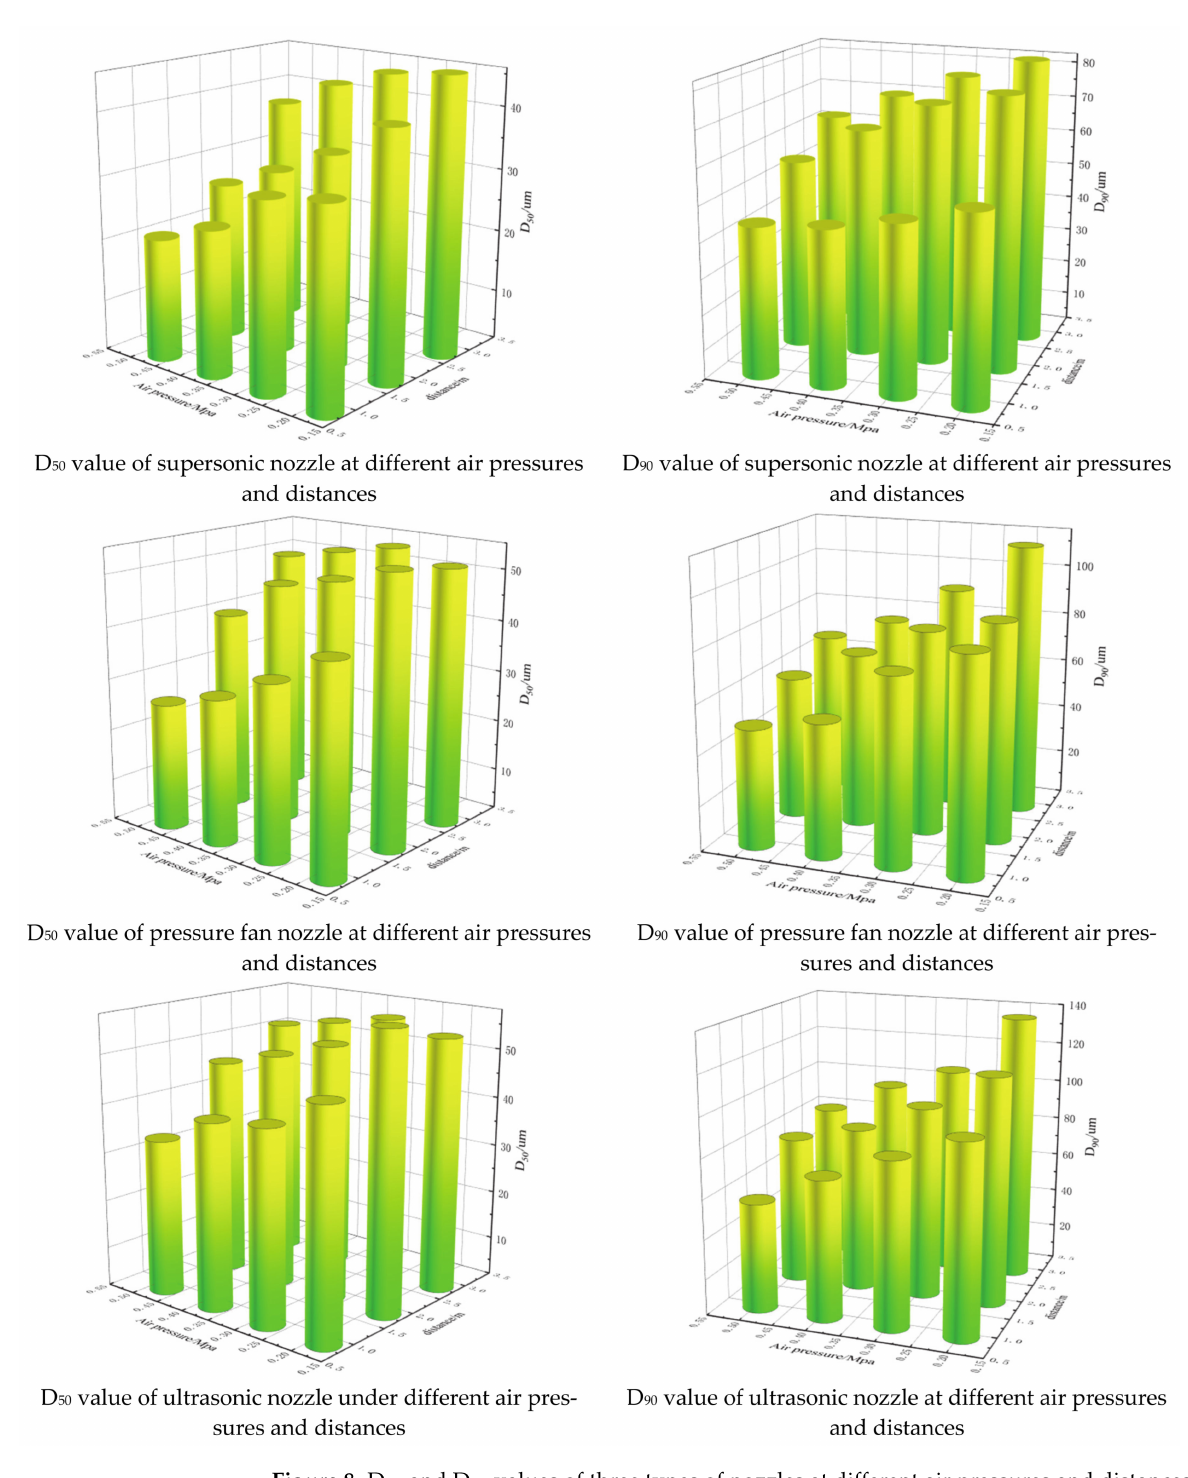
Figure 8. D 50 and D 90 values of three types of nozzles at different air pressures and